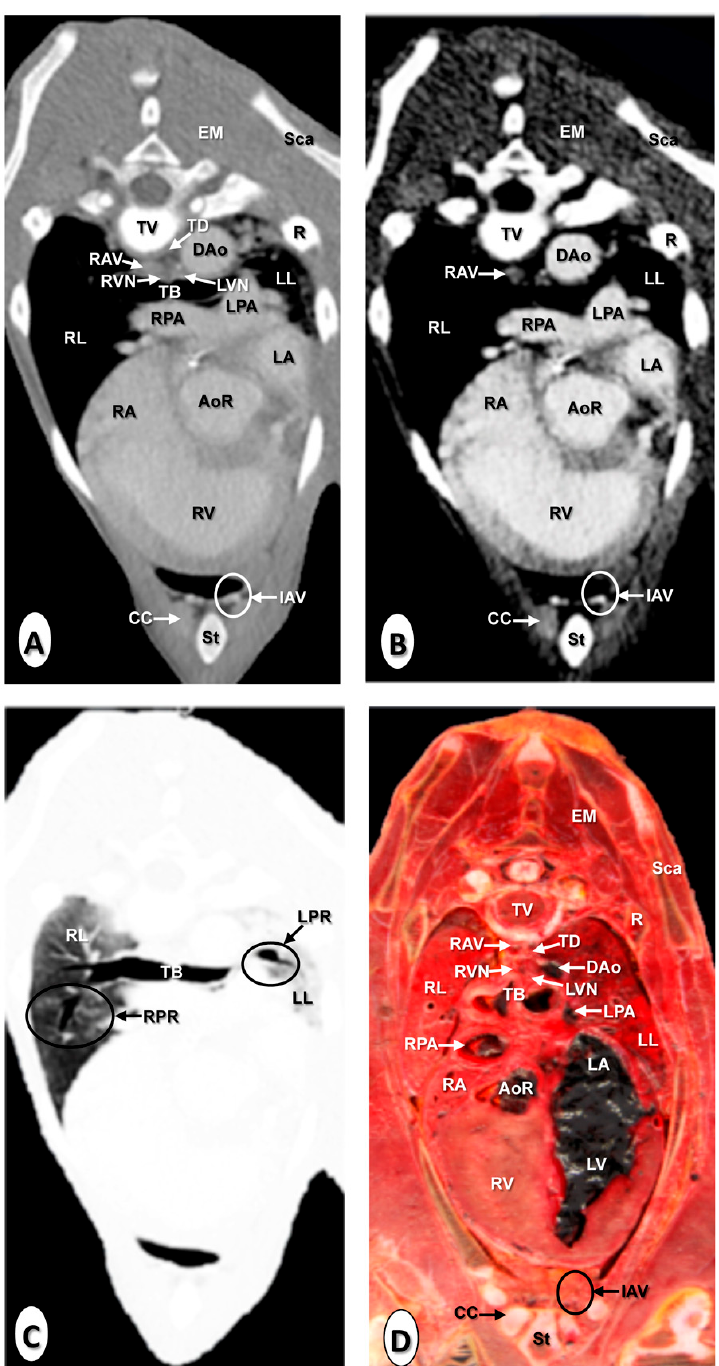
Figure 4. Transverse images at the level of the pulmonary arteries. ( A ) CT bone window; ( B ) CT mediastinal window; ( C ) CT lung window; and ( D ) anatomical section. These images are displayed so that the right side of the foal is to the viewer’s left and the dorsal view is at the top. Aortic root (AoR); descending aorta (Dao); epaxial muscles (EM); internal thoracic artery and vein (IAV); left lung (LL); left pulmonary artery (LPA); left pulmonary root (LPR); left vagus nerve (LVN); rib: Costal bone (R); rib: Costal cartilage (CC); right atrium (RA); right azygos vein (RAV); right lung (RL); right pulmonary artery (RPA); right pulmonary root (RPR); right vagus nerve (RVN); right ventricle (RV); scapula (Sca); sternum (St); thoracic duct (TD); thoracic vertebra (TV); and tracheal bifurcation (TB).